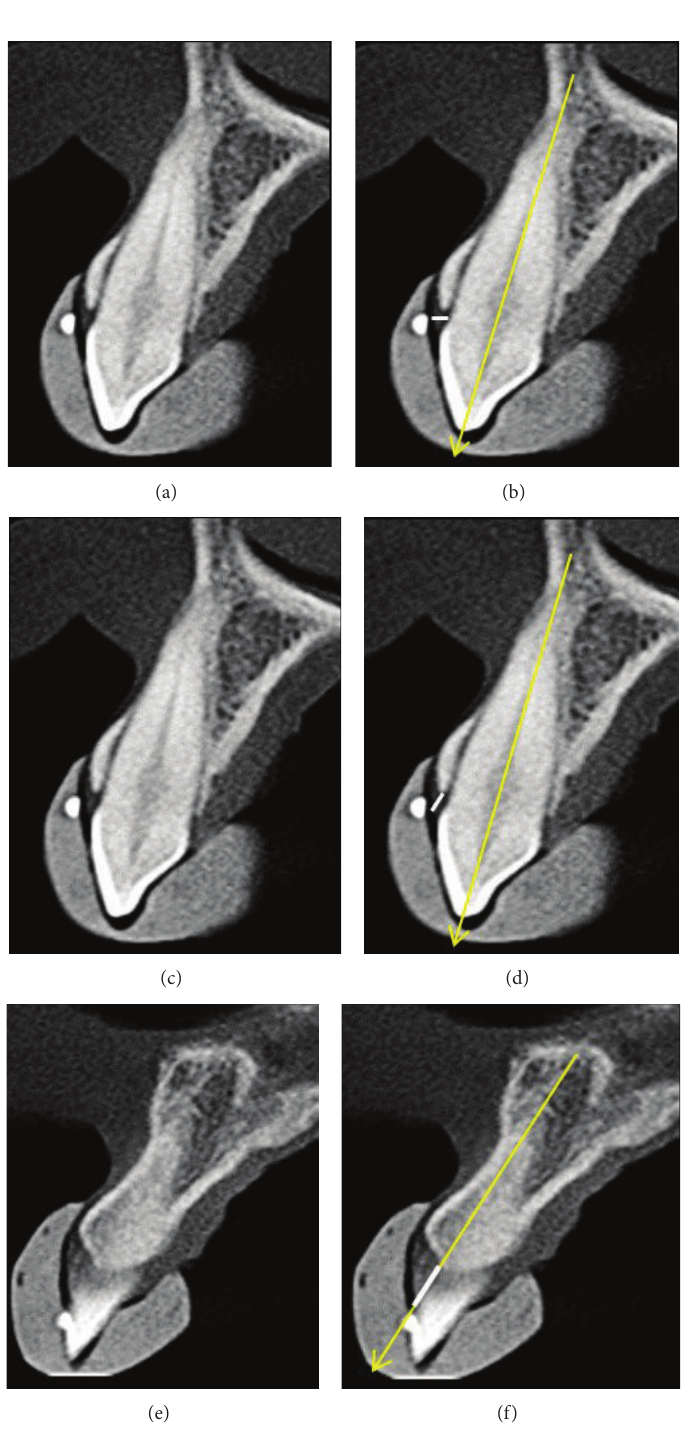
Figure 2: (a) Transversal slice of tooth 13 evidencing hyperdense and round mark. (b) Measuring gingival thickness (GT, white line, perpendicular to the long axis of the tooth). (c) Transversal slice of tooth 13 evidencing hyperdense and round mark. (d) Measuring the distance between the gingival margin and the vestibular bone crest (GMBC-V, white line, parallel to the long axis of the tooth, traced from the gingival margin to the vestibular bone crest). (e) Transversal slice of the region between teeth 11 and 12 with hyperdense and round mark at the tip of the interproximal papilla. (f) Measuring the distance between the gingival margin and the interproximal bone crest (GMBC-I, white